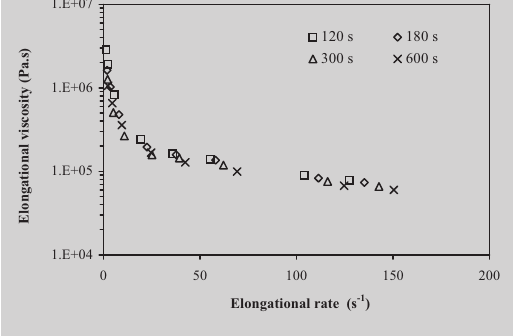
Figure 13 (left ): Elongational viscosity as a function of elongational rate of uncured blends as determined from capillary results. Figure 14 (middle): Plots of apparent shear vis- cosity measured by capillary rheometer ( ‡ ) and complex viscosity determined from RPA 2000 ( · ) as a function of shear rate or frequency in filled uncured CPE/NR blends with various mixing time. Figure 15 (right): Plots of true shear viscosity measured by capillary rheometer ( ‡ ) and dynamic viscosity determined from RPA 2000 ( · ) as a function of shear rate or frequency in filled uncured CPE/NR blends with various mixing